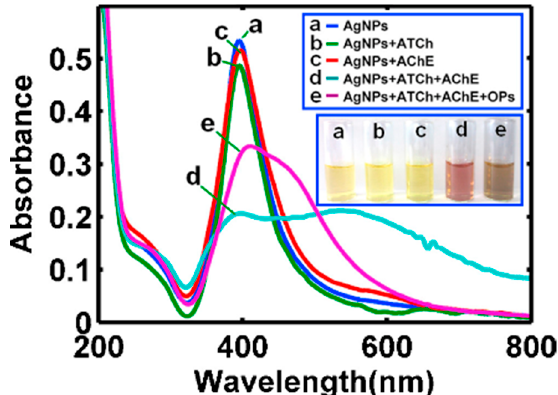
Figure 10. UV–vis absorption spectra of dispersed AgNPs (a), AgNPs with acetylthiocholine (b), AgNPs with acetylcholinesterase (c), AgNPs with acetylthiocholine and acetylcholinesterase (d), AgNPs with acetylthiocholine and acetylcholinesterase in presence of dipterex (e). Each of the samples was heated in a water bath at 37 ◦ C for 15 min before analysis. Inset: corresponding photo images of the reaction solutions after equilibration at 37 ◦ C for 15 min (Reference. [145]) .